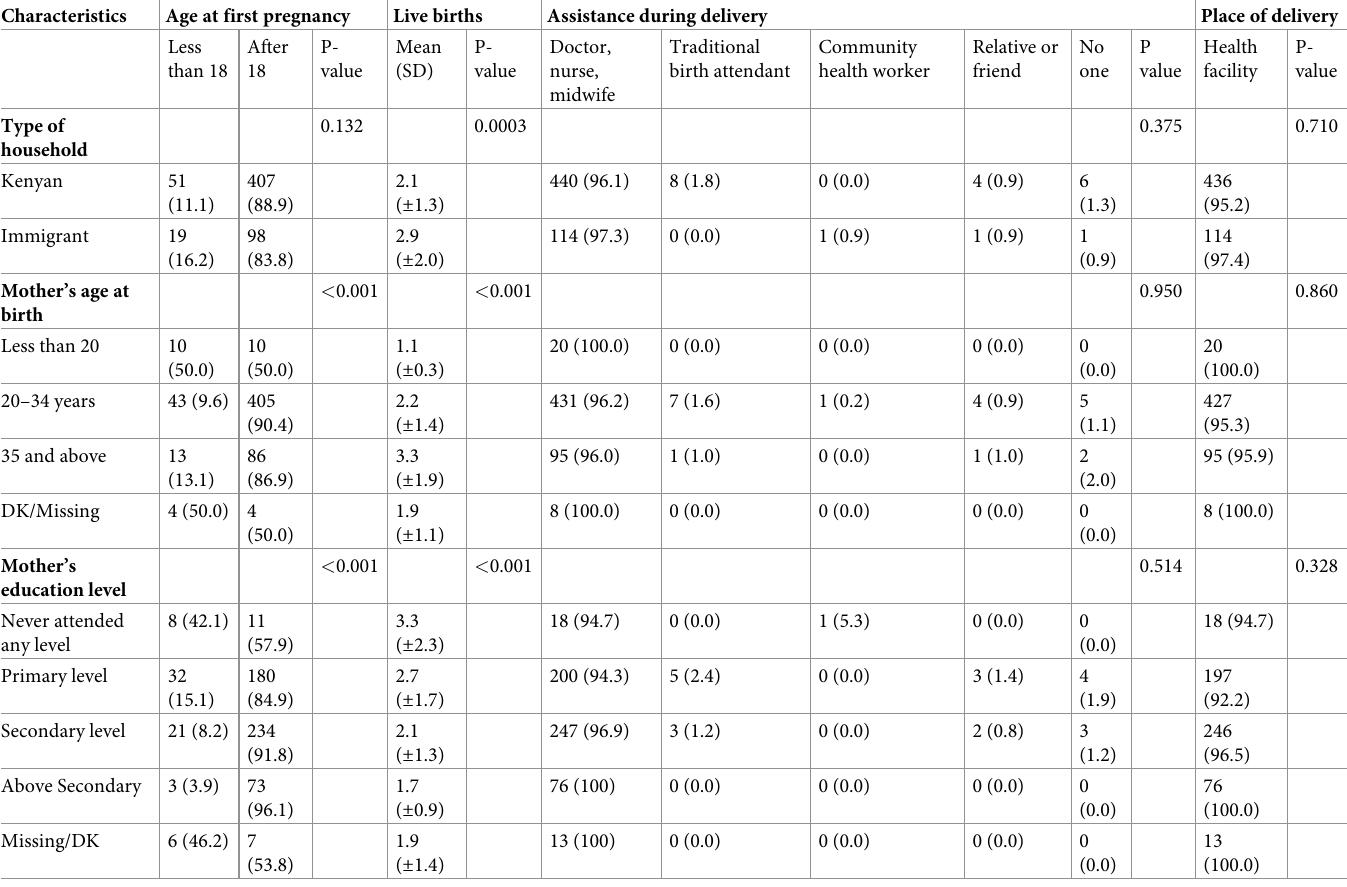
Table 4. Child delivery practices among mothers of children aged 0–2